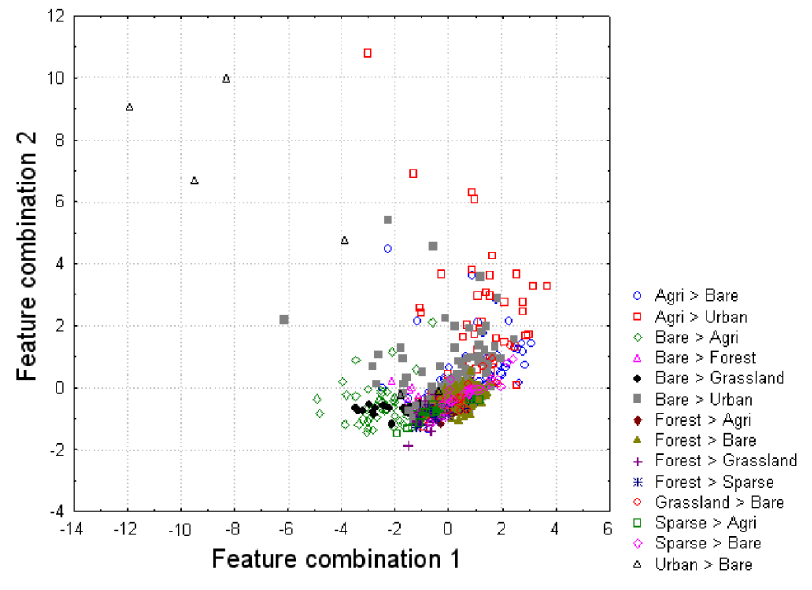
Figure 2. The feature space showing the differentiation of the 14 LC change types identified at the six test sites. Feature Combination 1 and Feature Combination 2 are the best combinations of discriminant features (such as NDVI, texture and multivariate alteration detection (MAD)